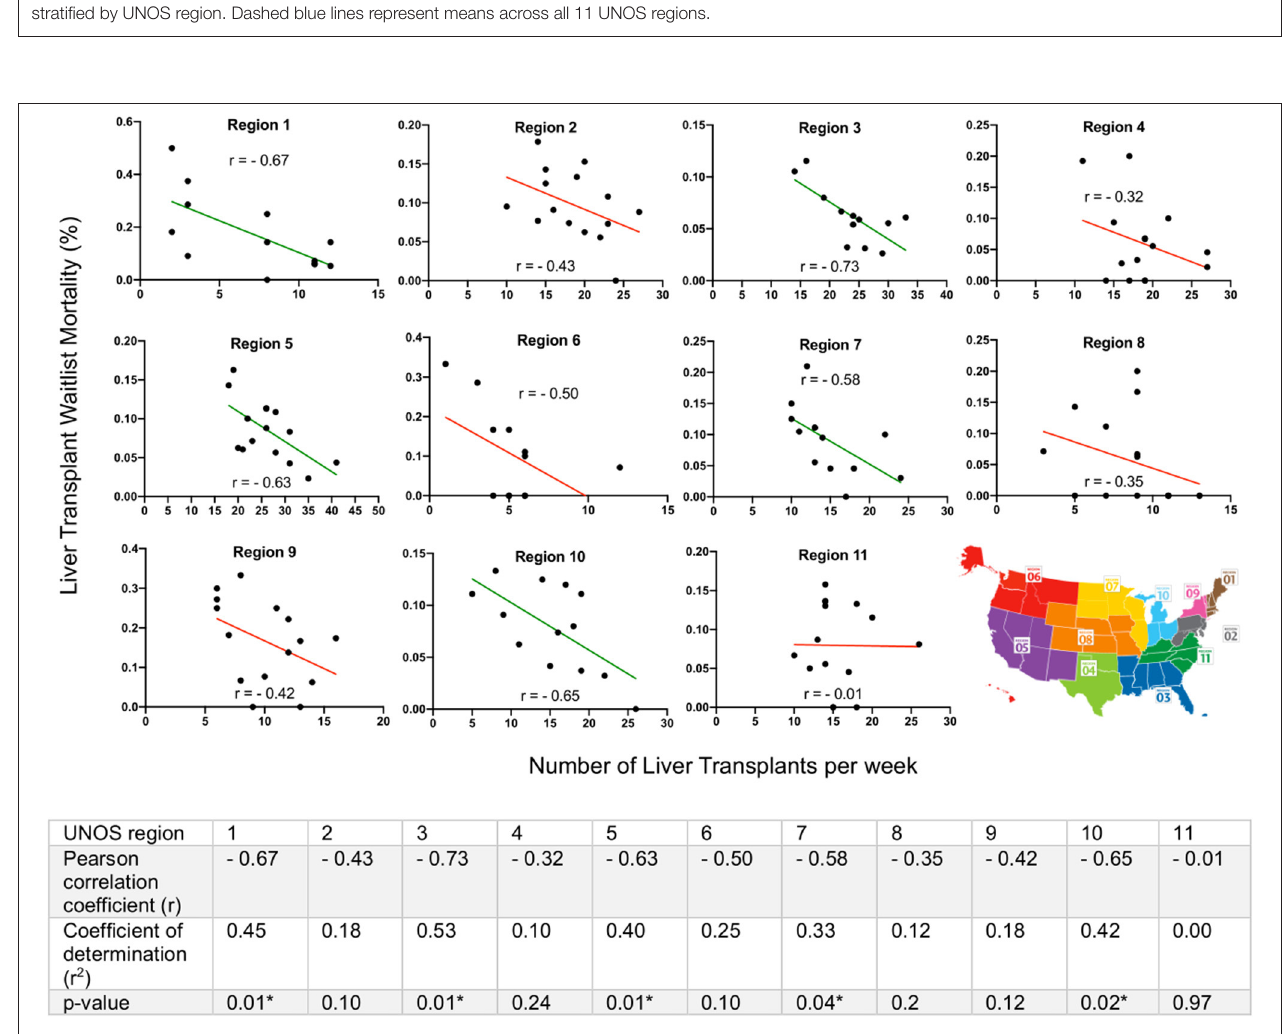
FIGURE 3 | Regional variation in liver transplant (LT) activity and waitlist mortality in the Unites States during COVID-19. Pearson correlation coefficients ( r ) assessed the strength of association between the number of LTs performed in the first 15 weeks of 2020 and LT waitlist mortality, stratified by United Network for Organ Sharing (UNOS) region. All 11 UNOS regions exhibited a negative association, however, there was a large amount of regional variation (r range − 0.73 to − 0.01). Green lines indicated statistically significant negative associations, red lines indicated lack of statistical significance. Coefficients of determination ( r 2 ) calculated from the square of the Pearson correlation coefficient. *Significance level p <